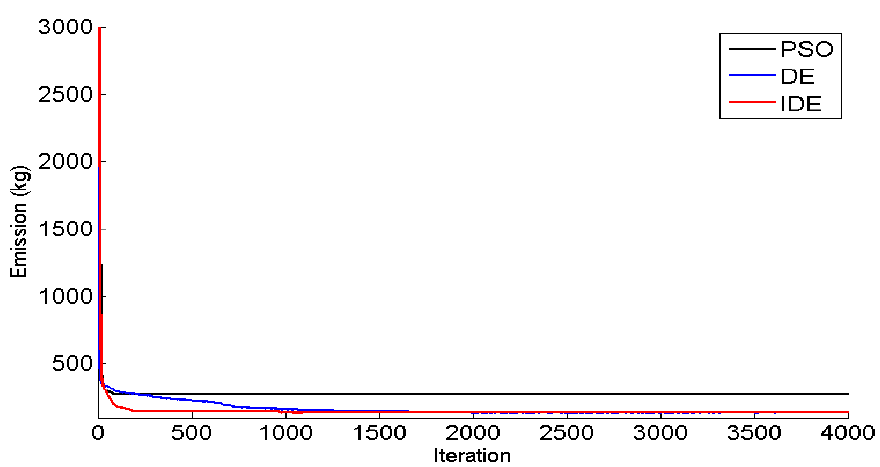
Figure 2. Cost convergence diagram in different methods without considering the limitations of power exchange with upstream network.